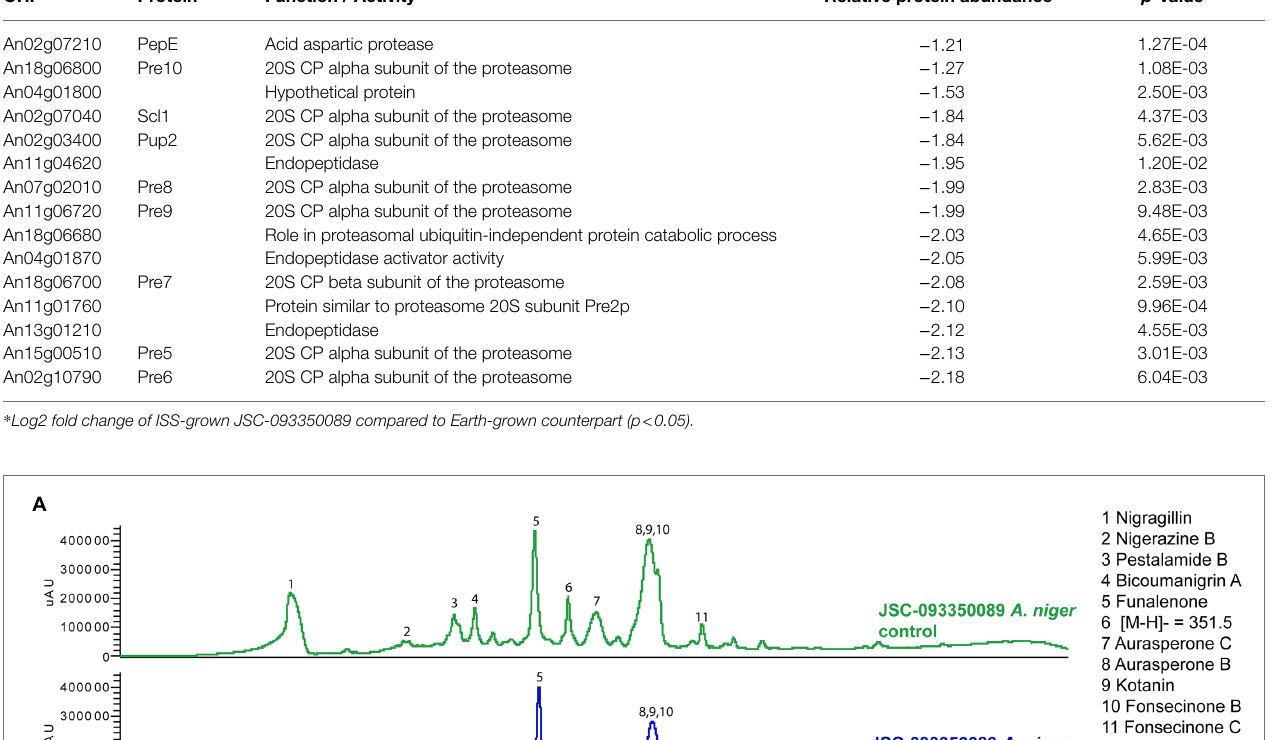
TABLE 6 | Differentially expressed proteins involved in protein catabolic process. ORF Protein Function / Activity Relative protein abundance* p -value